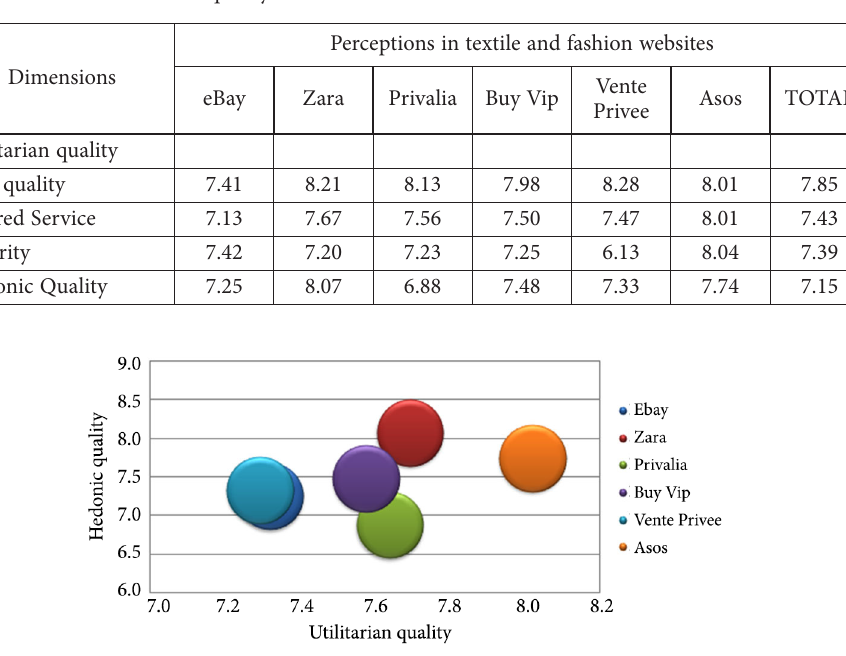
Table 5. Means for e-service quality dimensions